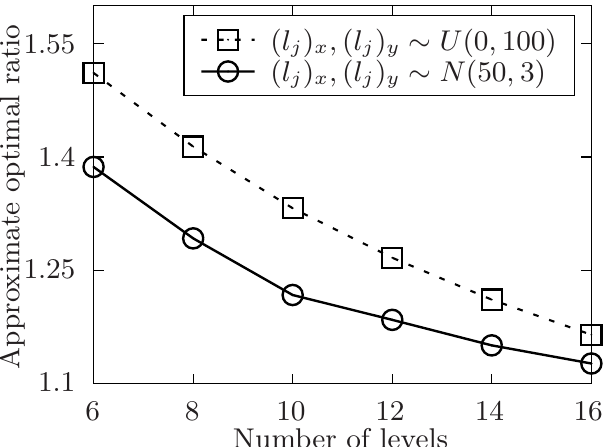
Figure 8. The approximate optimal ratio of the proposed algorithm vs. different n when ( l j ) x , ( l j ) y ∼ U ( 0,100 ) or N ( 50,3 ) .